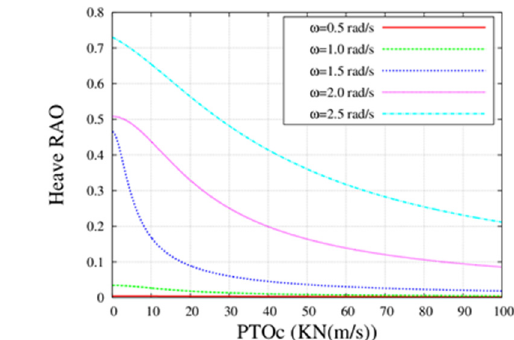
R Figure 9. The motion response of the MJWEC for different radius ratios and draft ratios..